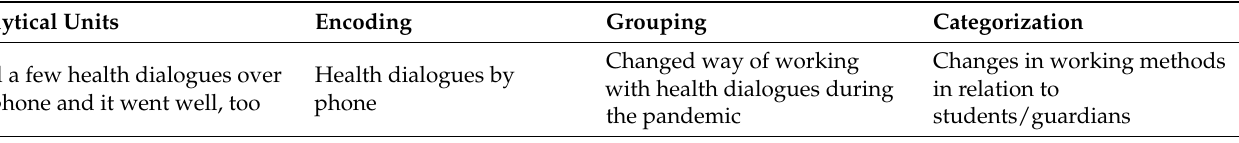
Table 2. The results consist of three categories with a common thread as an overall level. Table 2. An overview of the analysis